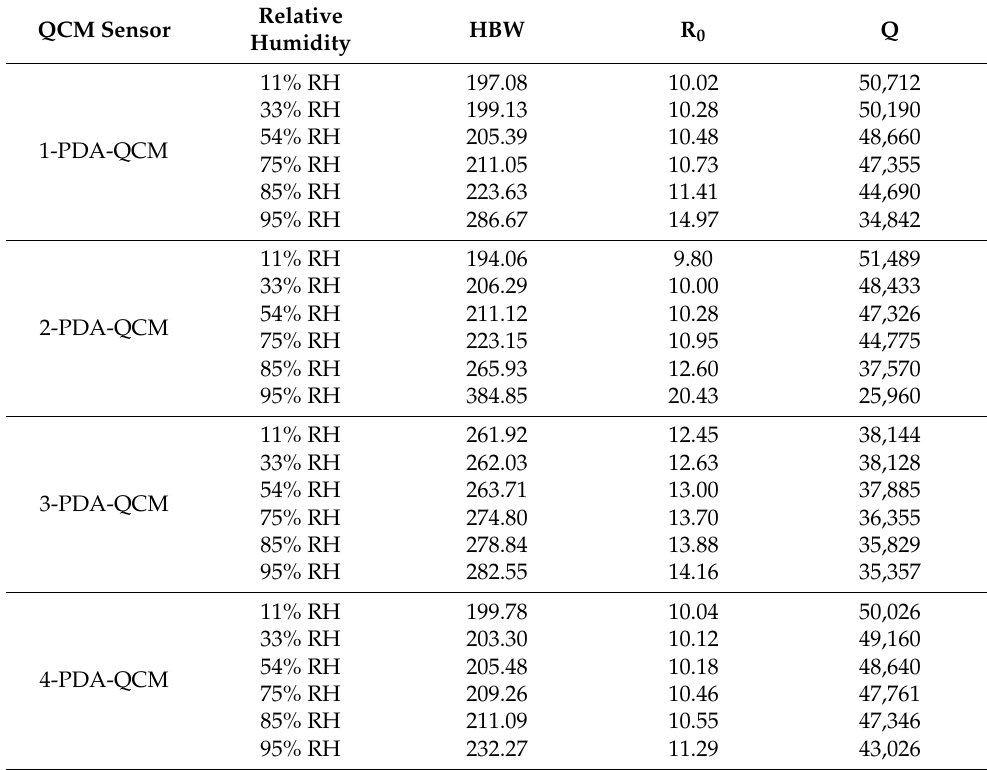
Table 2. Half-band widths, equivalent resistance values, and quality factors of PDA-QCM humidity sensors measured in the range of 11% RH to 95% RH with different in situ growth times.